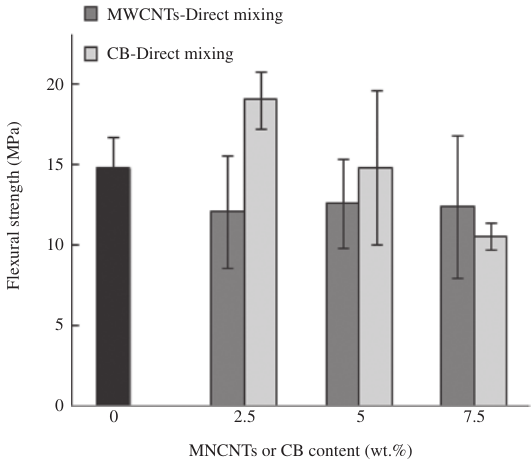
Figure 7: The effect of the MWCNTs and CB on the flexural strength of the PP/SG/xGnP composites.